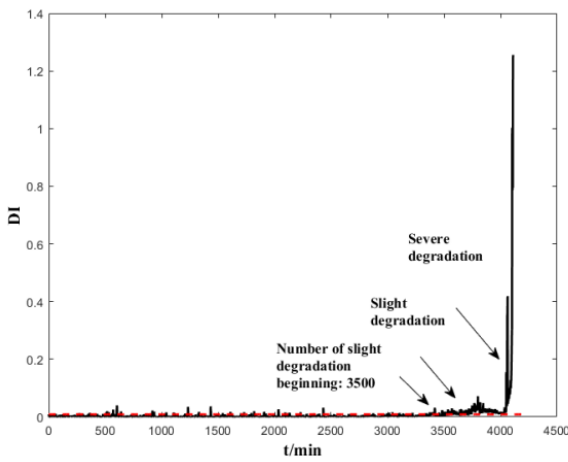
Figure 10. Performance assessment of the whole life time of B1 by SVDD.